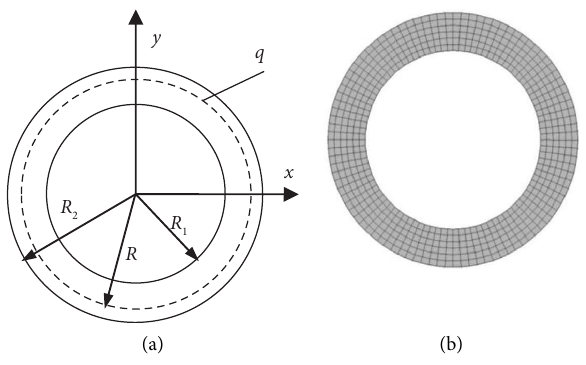
Figure 2: Annular thick-plate model. (a) Geometric model. (b) Mesh model.